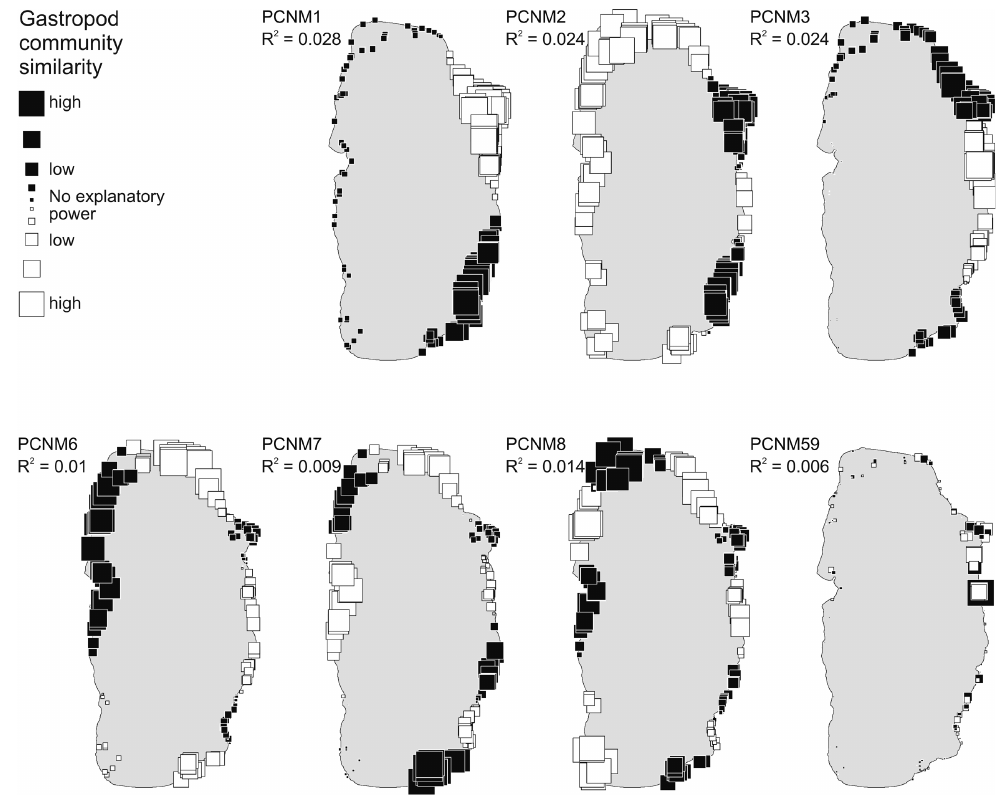
Fig. 5. Spatial prediction of community similarities of Lake Ohrid utilizing PCNM eigenfunctions. Six broad and one fine scale vectors explain 11.5% of the variation of gastropod communities. Within each eigenfunction, groups of equally-coloured squares indicate similar gastropod communities. Increasing square size shows higher similarity (note that small squares may not have sufficient explanatory power). Higher eigenfunctions represent increasingly smaller spatial scale predictions. Therefore, the frequency of alternating groups of black and white squares